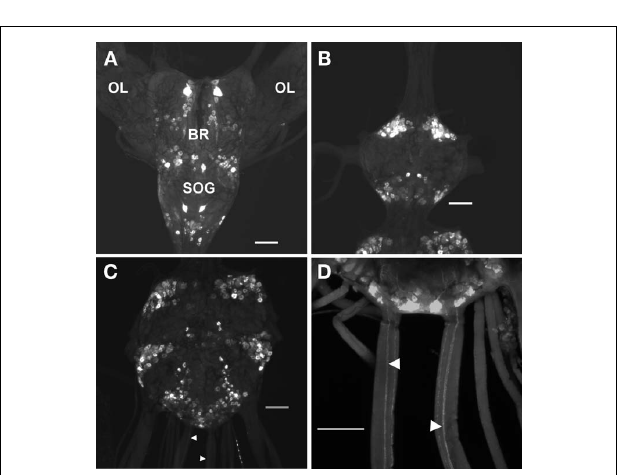
FIGURE 4 | Detection of proctolin by MALDI-TOF MS/MS in fifth instar R. prolixus . The peptide with MH + : 649.3778 from MALDI-TOF MS of a RPHPLC fraction from CNS of R. prolixus fifth instars was selected for fragmentation experiments. Prominent y- and b-type fragments of ion signal 649.3778 were analyzed manually, and the deduced sequence, an exact match to proctolin, is shown. M, mass number; Z, atomic number.